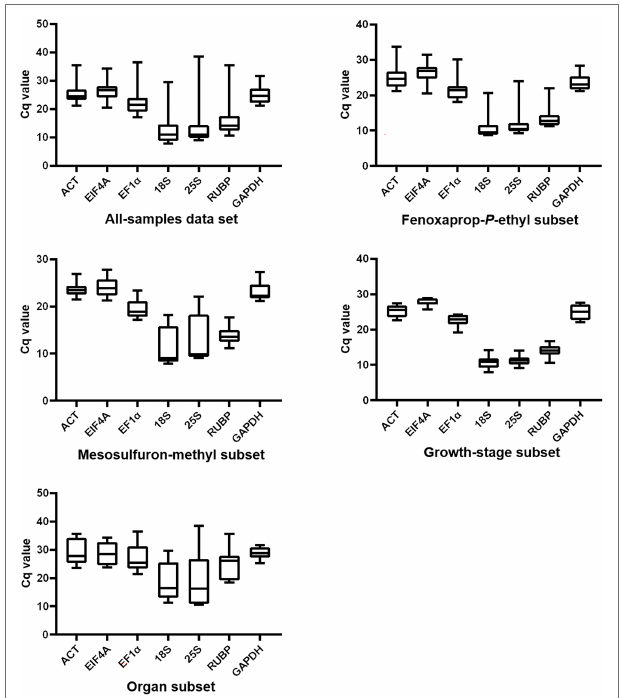
FIGURE 1 | Overview of transcript levels of seven candidate reference genes in Polypogon fugax under herbicide stress as well as other experimental conditions. Top and bottom borders represent the 25th and 75th percentiles, respectively. The horizontal line within the box indicates the median. Whiskers represent the maximum and minimum